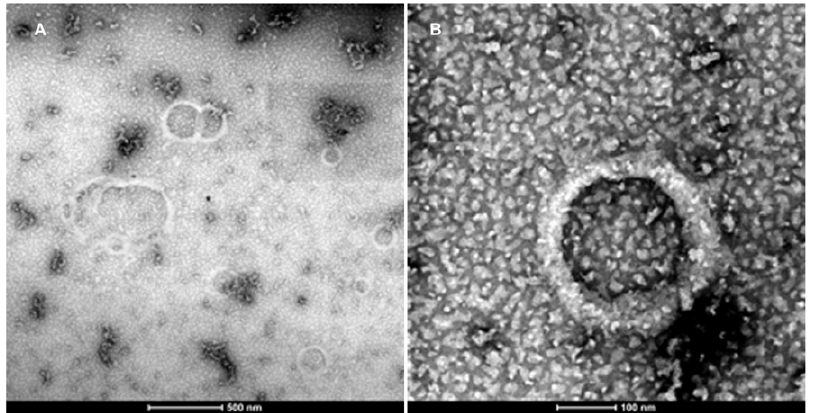
Figure 4. Scanning Transmission Electron Micrograph (STEM). Vesicles were prepared with 30% CH 3 -Hg label in both the h 5 and h 9 peptides at 0.1 mM concentration were negatively stained using a multi isotope 2% Uranyl acetate (Uranium bis(acetato)-O)dioxo-dihydrate) aqueous solution. The images were captured using annular dark field mode was then inverted to produce the final image. doi:10.1371/journal.pone.0045374.g004 Circular dichroism (CD) spectra support the b - or extended performing curve fitting and analyzing the distribution, using conformation of the assembled branched-peptides structures Dynals (see Methods) yielded a mean auto correlation time of (Fig. 6A, solid line) at pH 7 in 5 mM NaCO 3 solution, with 1.85 ms for the major distribution (Fig. 5). a bisignate profile characteristic of a b -structure with a minimum